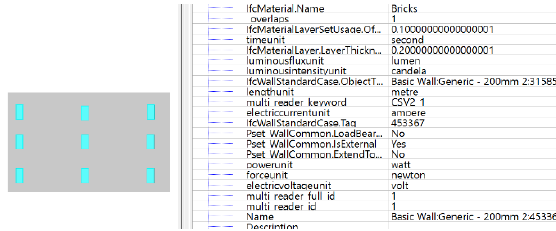
Figure 8: IFC material of walls transferred to CityGML LoD